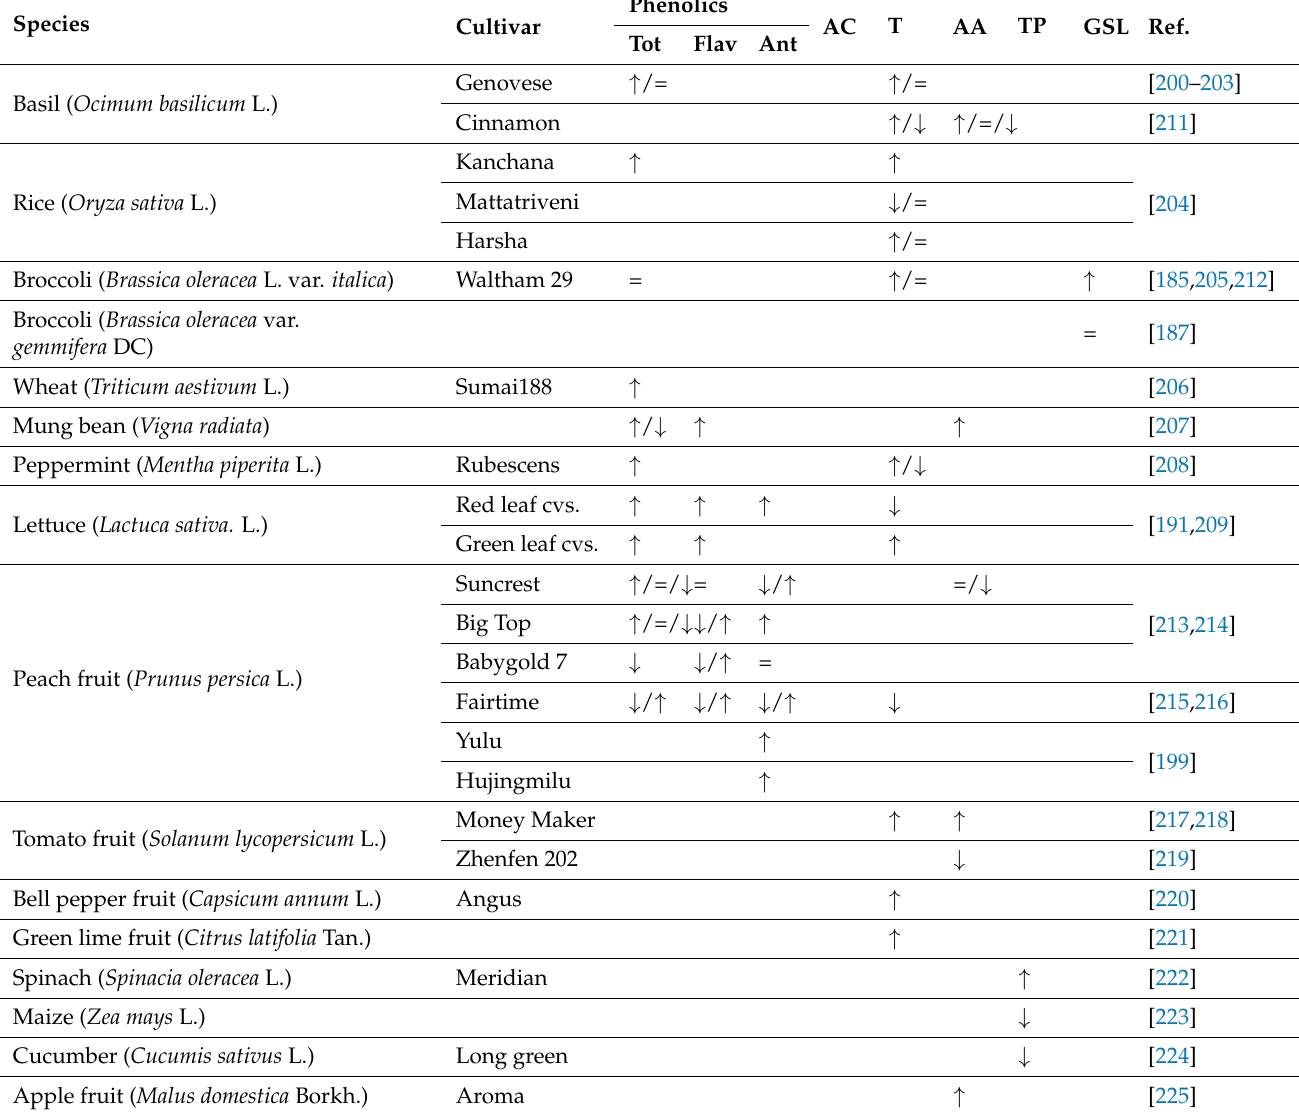
Table 5. Biochemical responses of crops and plants of food interest to UV-B wavelengths considered in this review. Tot, total phenolics; Flav, flavonoids; Ant, anthocyanins; AC, antioxidant capacity; T, terpenoids; AA, ascorbic acid; TP, tocopherols; GSL, glucosinolates. For each plant species and cultivar, and for each secondary metabolite or metabolic class considered, the symbols “ ↓ ”, “ ↑ ” and “=” mean a decrease, increase or no variations, respectively, compared to the control plants of each